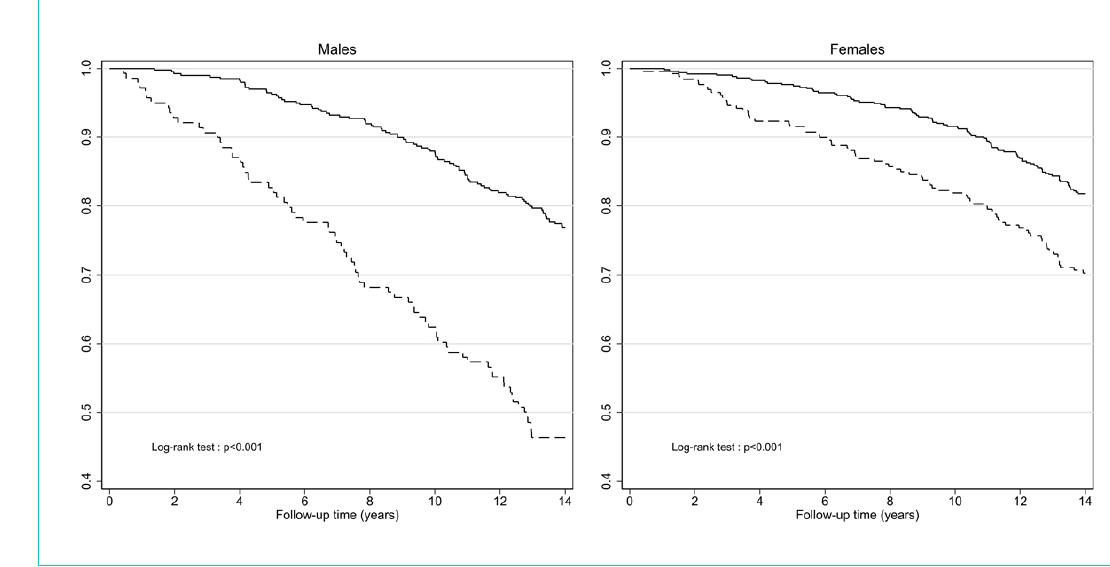
Figure 2: Kaplan-Meier survival curves according to the frailty phenotype at baseline, by sex. Continuous line: non-frail, dotted line: pre-frail or